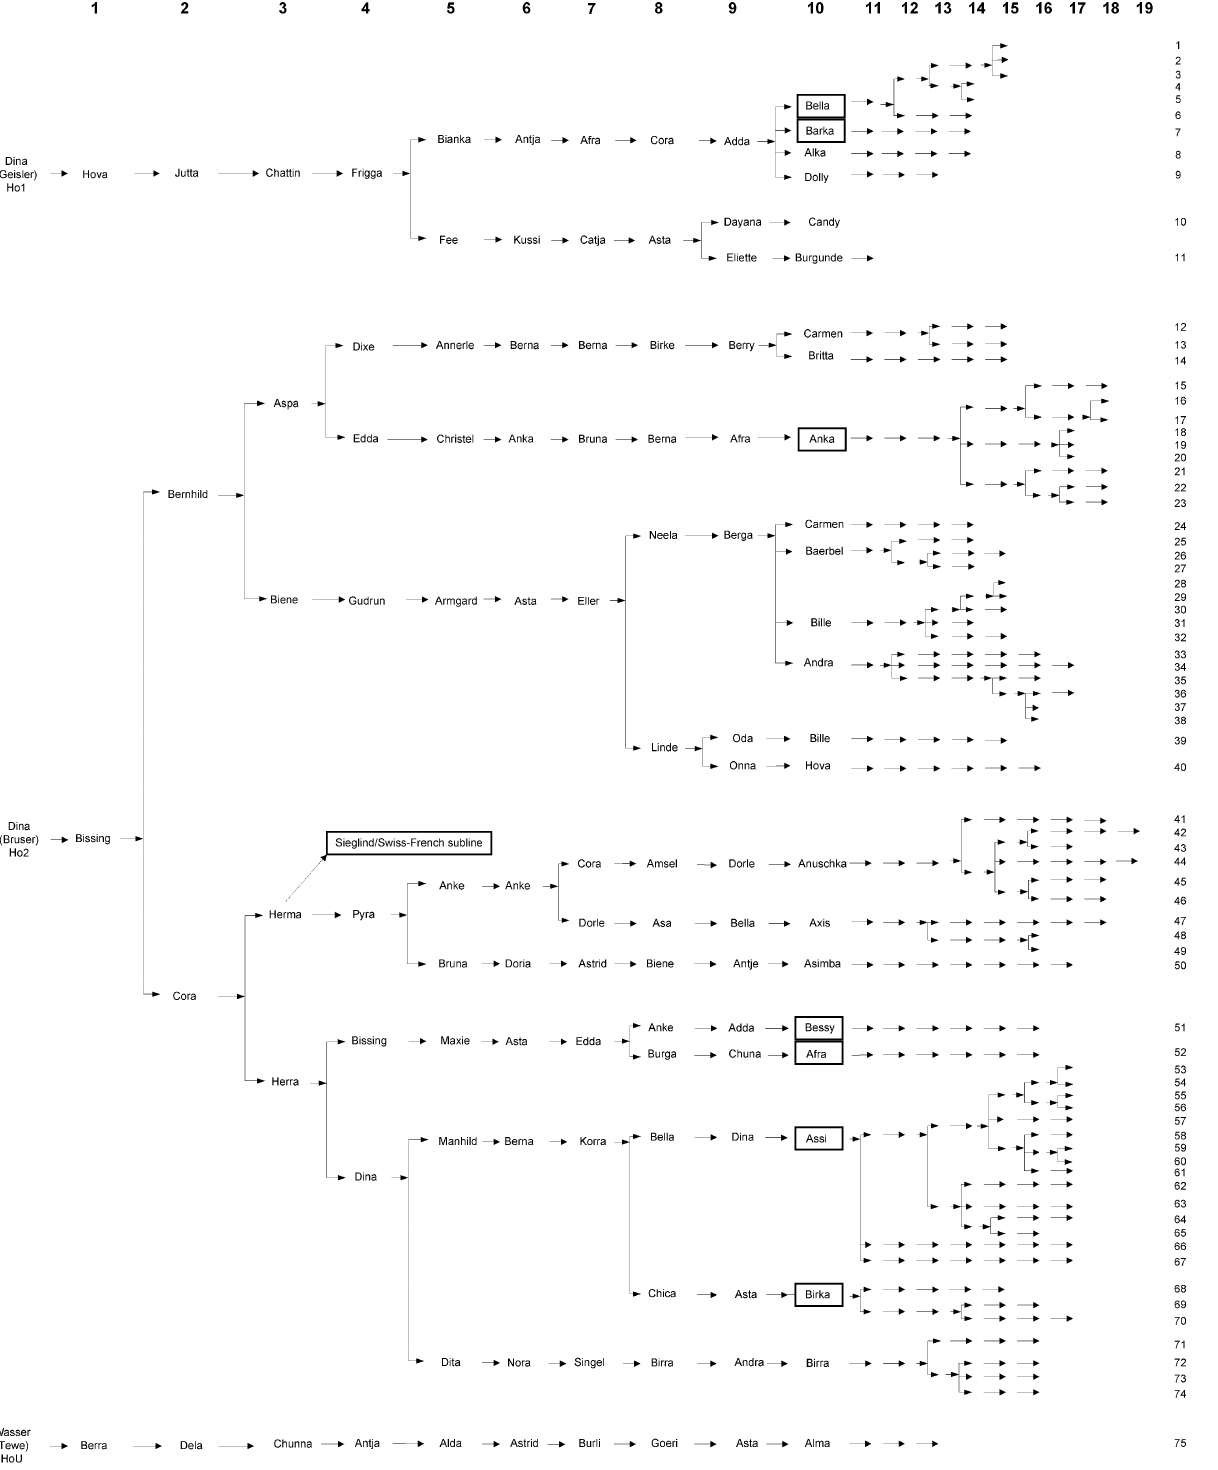
Figure 2. Simplified scheme of three dam lines of German Hovawart dogs including data for the period up to 1989. Names of ancestors of Polish Hovawarts, hair samples of which were used in laboratory mtDNA analysis by Gła˙zewska et al. (2012), are given in rectangles. Right column – subline